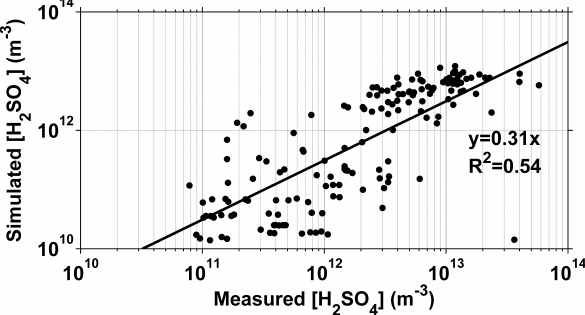
Fig. 11. Regression analysis between hourly averages of measured and simulated sulfuric acid concentrations [H 2 SO 4 ] (m − 3 ) for event days during the NIFTy experiment. As shown, simulated val- ues are negatively biased relative to the in situ measurements.